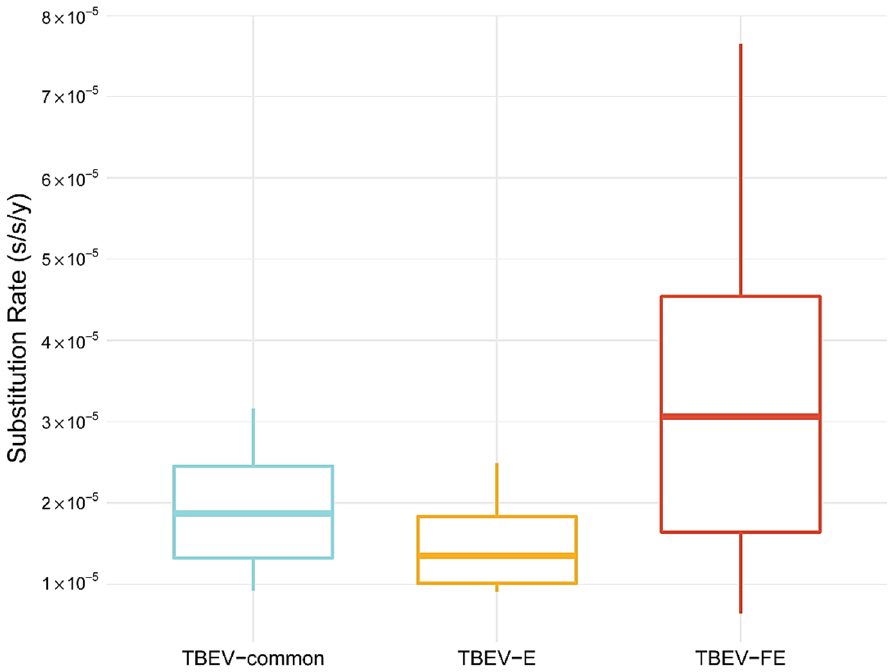
Figure 3. Comparing the substitution rates of the common clade of tick-borne encephalitis virus (TBEV-common), the European (TBEV-E) and Far-Eastern (TBEV-FE) subtypes. The Siberian subtype of TBEV (TBEV-S) was not included in the analysis since it had no temporal structure according to permutation test results.